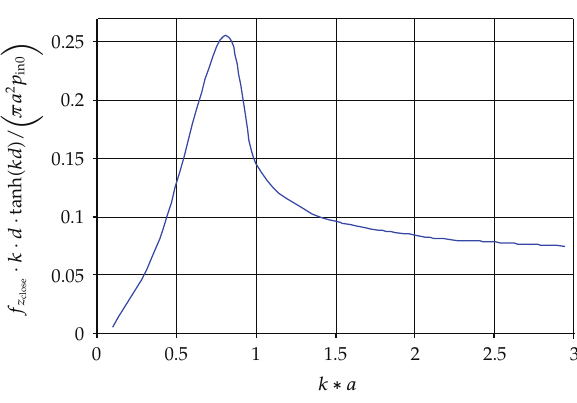
Figure 3: Vertical exciting force on the OWC device due to a unit inner pressure head.